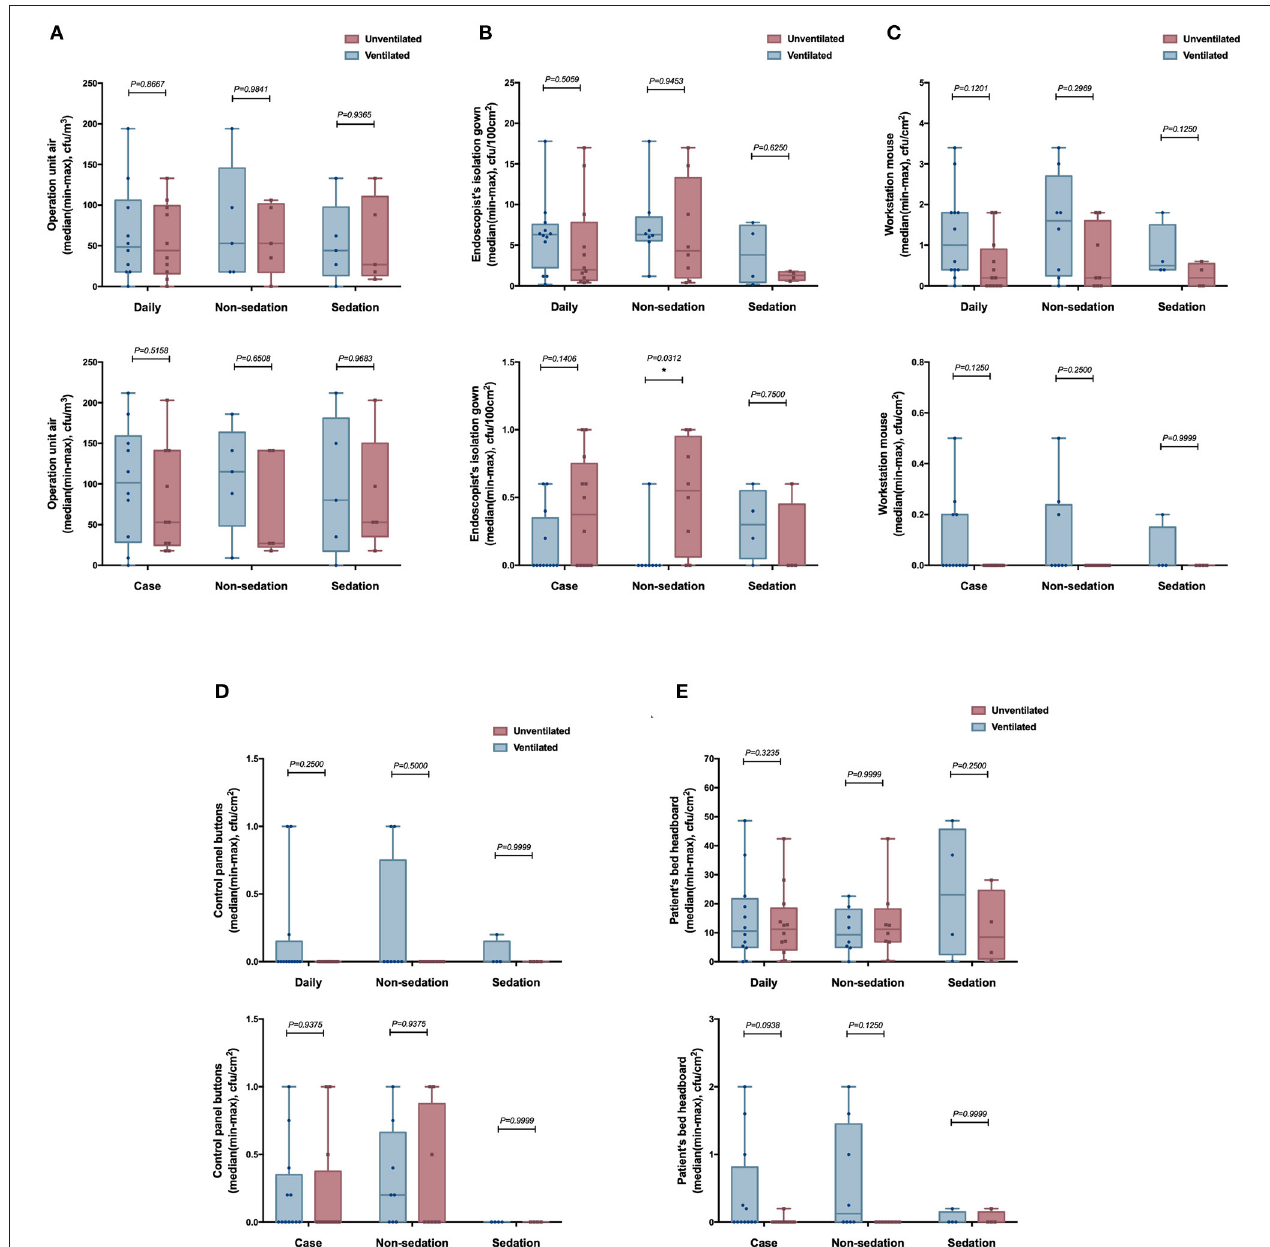
FIGURE 2 | The number of culture samples in the level of colony-forming units (CFUs) for the surface of the endoscopy unit between the daily room disinfection and the after-each-case room disinfection. (A) operation unit air; (B) isolation gown of the endoscopist; (C) workstation mouse; (D) control panel buttons; and (E) bed head of the